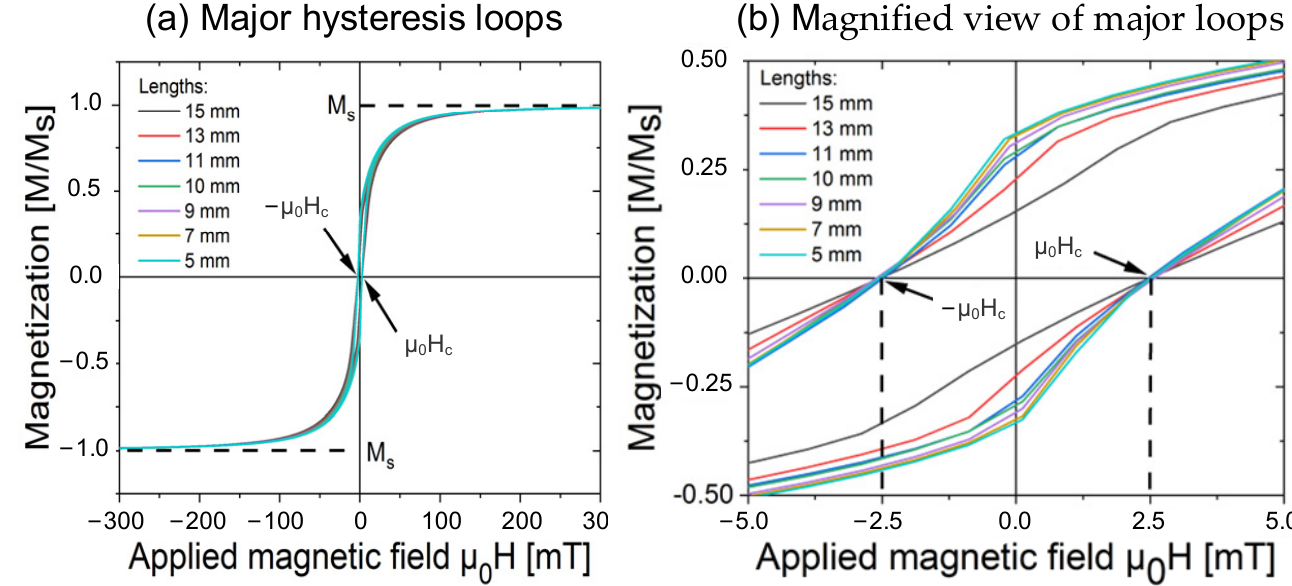
Figure 6. ( a ) Magnetization curves (major loops) of Wiegand wires at varying lengths and at a diameter of 0.25 mm. ( b ) Magnified views of the major loops for the applied field µ 0 H from − 5 to 5 mT.